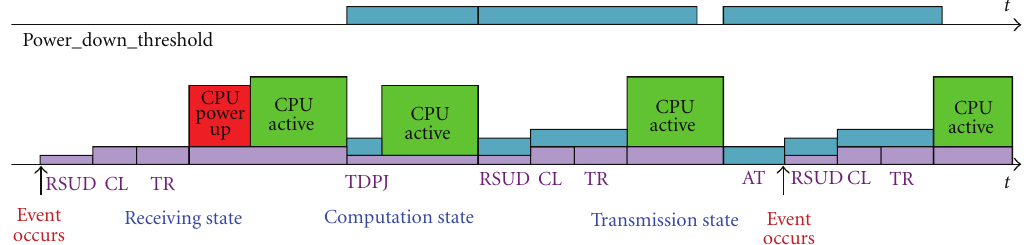
Figure 19: Energy diagram of no CPU power ups (after the first one) in one system cycle for closed model (not drawn to scale).